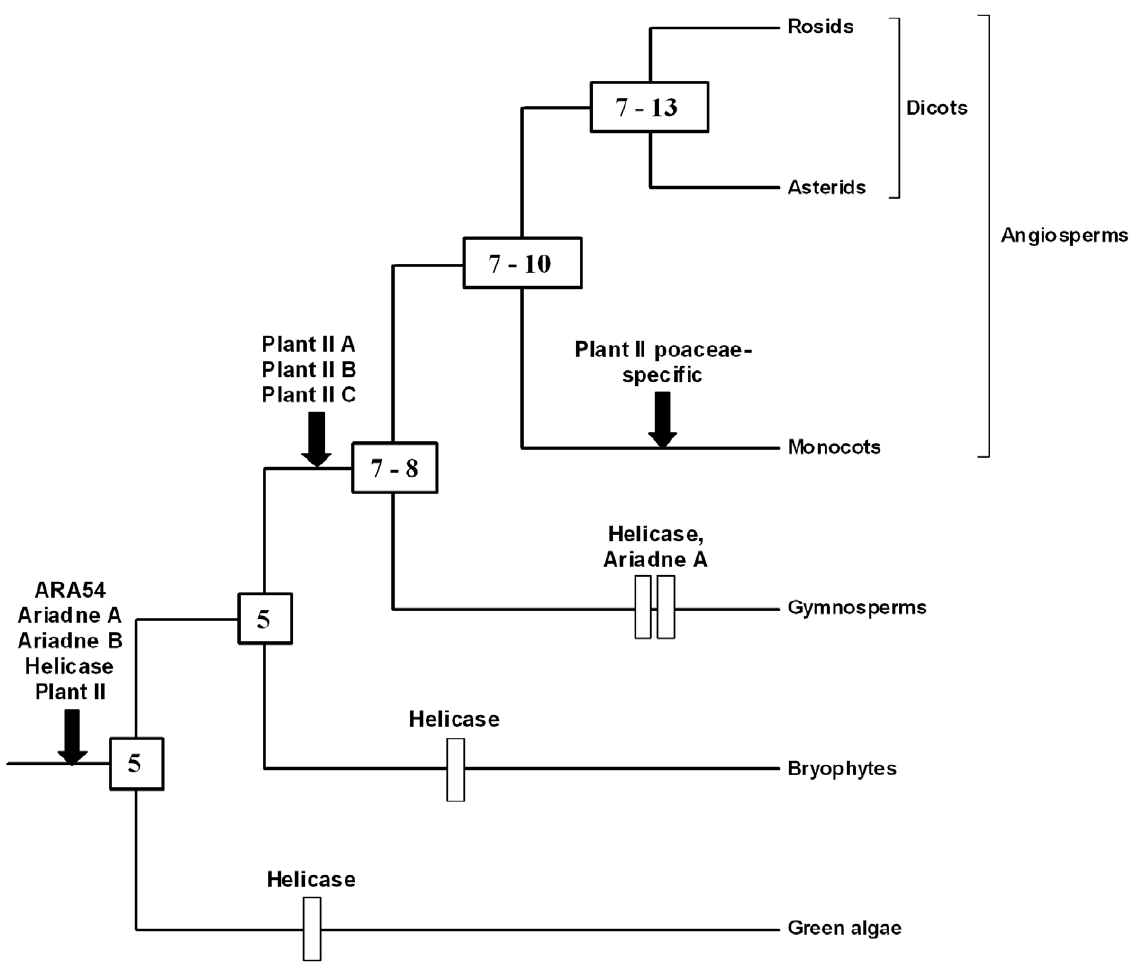
Figure 3. The most parsimonious hypothesis to explain the progressive diversification of plant RBR genes. This figure summarizes how this family may have diversified, according to the available data. Rectangles correspond to gene losses and arrows to gene emergences. The numbers in the internal nodes (boxes) correspond to the genes deduced to exist at that particular time. Ambiguities are due to the difficulties in establishing when lineage-specific duplications occurred (see text).